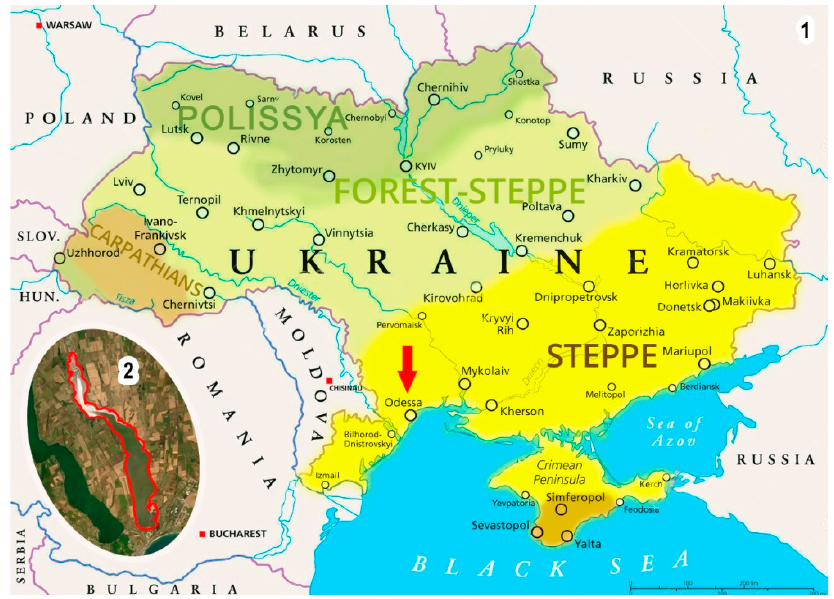
Figure 1. Location of Kuyalnik Estuary on the territory of Ukraine: 1—Map of Ukraine; 2—Kuyalnik Estuary on the map of Ukraine.